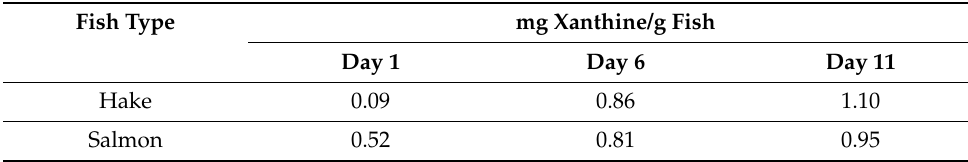
Table 5. Results of the determination of xanthine in fish samples. Fish Type mg Xanthine/g Fish